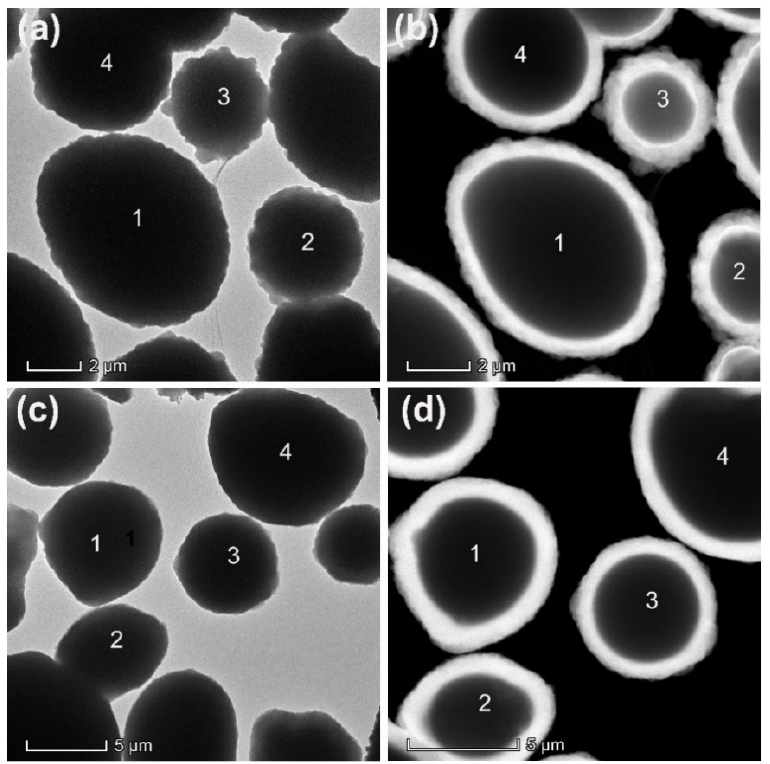
Figure 3. TEM and STEM images of SiO 2 -encapsulated SnZn 0.04 Cu 0.015 microspheres obtained via the interface-confined sol–gel method with different encapsulation times: ( a , b ) 3 and ( c , d ) 5.